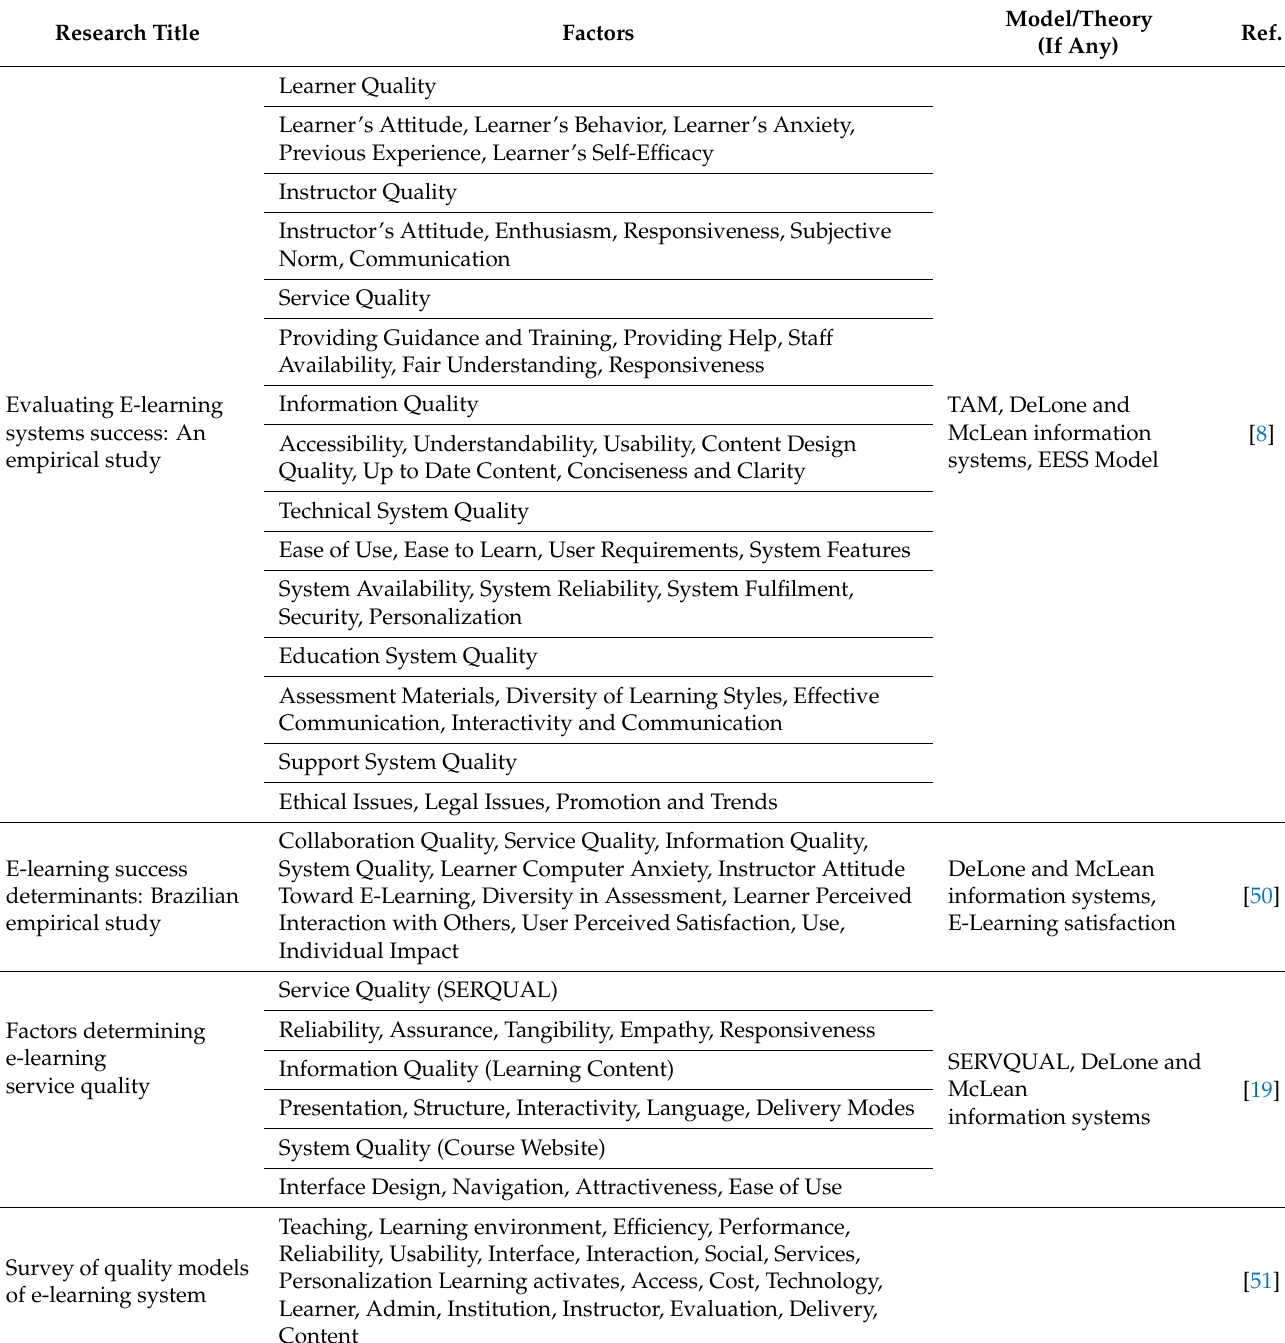
Table A2. E-Learning Service Quality Models and